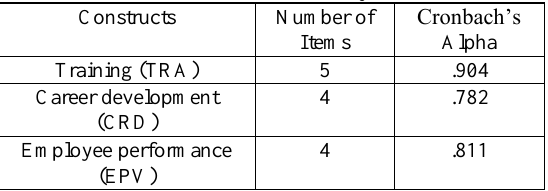
Table 1: Result for Reliability Statistics